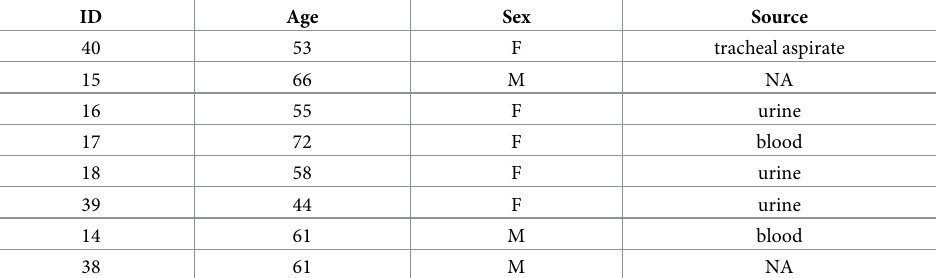
Table 2. Demographic profile and clinical characteristics of eight ESBL-producing Escherichia coli isolated from clinical patients admitted to the Segamat district